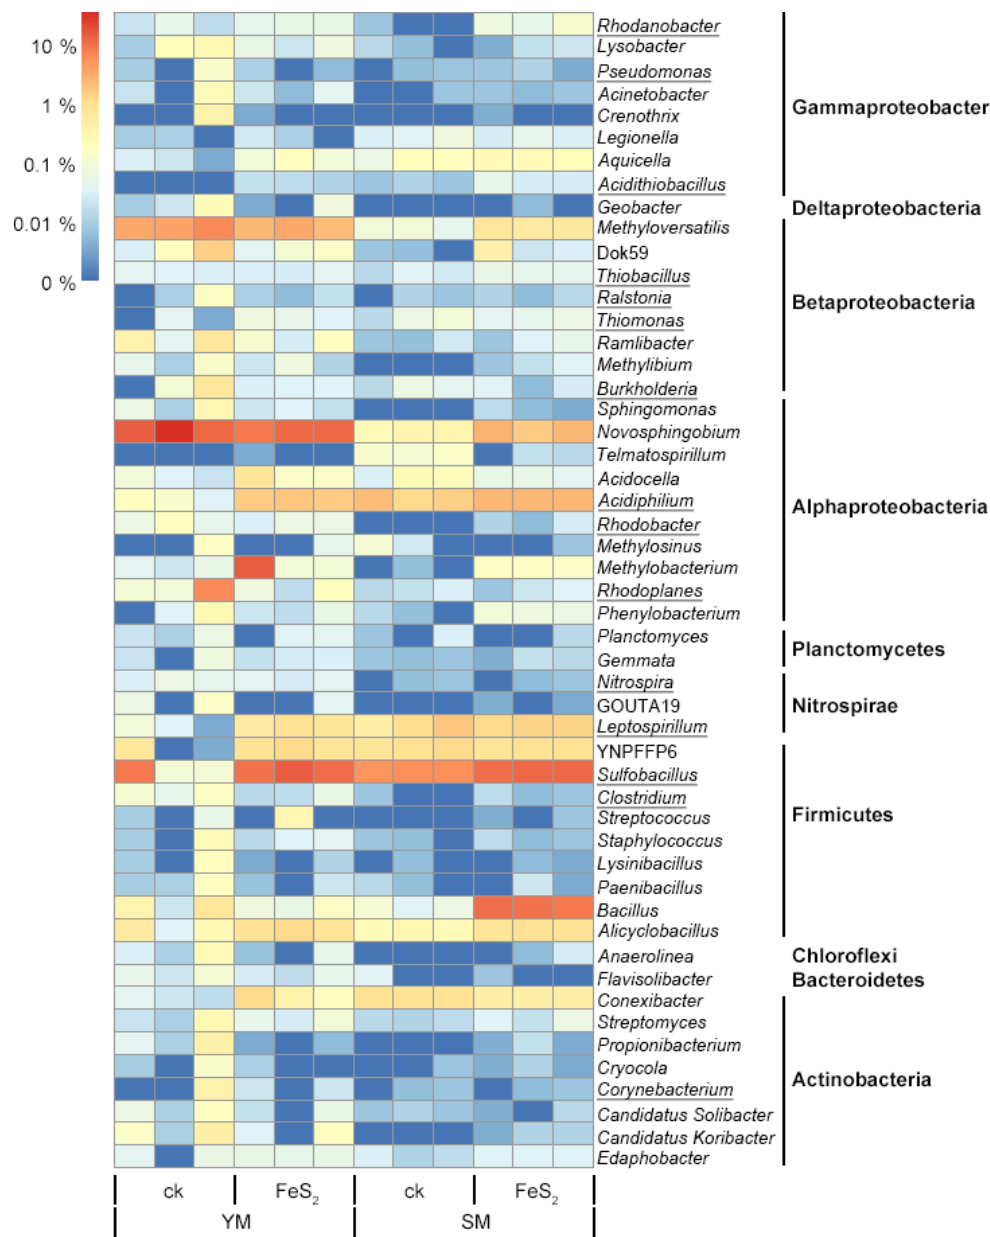
Figure 4. Heat map of the top genera with relative abundances above 0.02% in mine tailings. Autotrophic bacteria were marked with